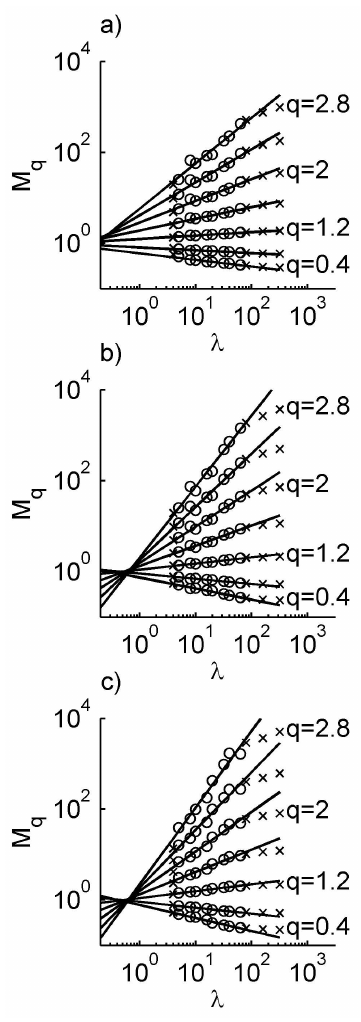
Fig. 4. The scaling exponent function, K(q) for (a) varying l sst , (b) varying T s with l sst = 10km and (c) varying U with l sst = 10km. The empirical estimated K(q) is showed with markers and the UM model fit is represented by full